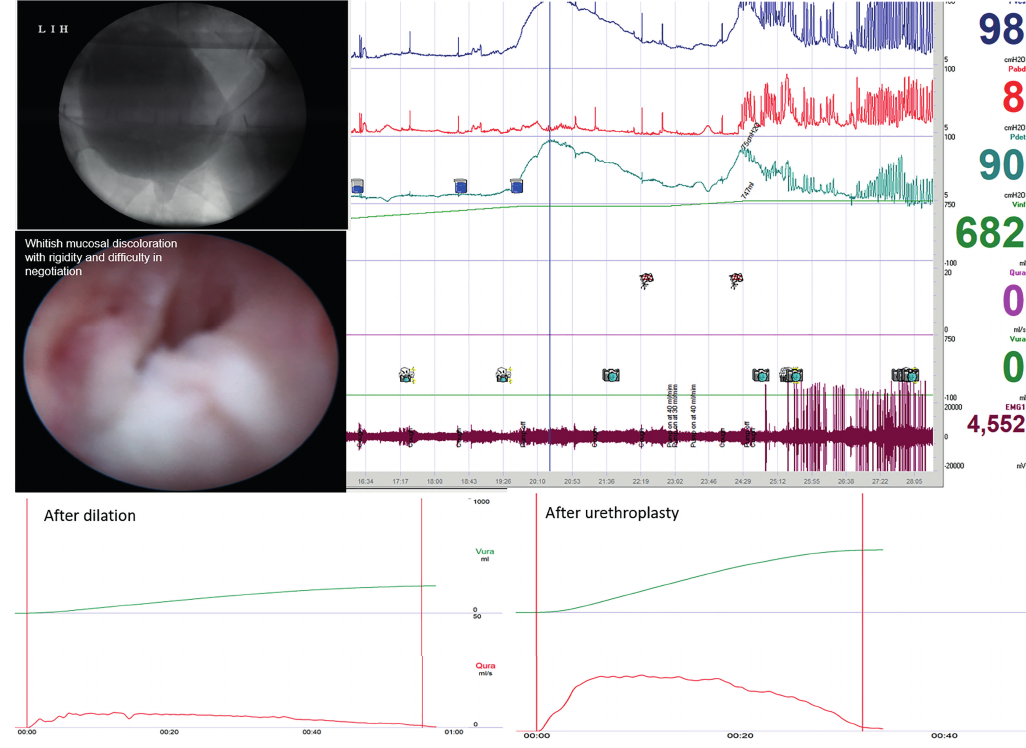
Figure 4 - 54-year-old lady with IPSS (28) with successful calibration showing VUDS and urethroscopic correlation with pDet@Qmax 90cmH2O, inability to void with proximal urethral ballooning evident during VUDS, stigmata of stricture as a whitish mucosal discoloration and rigidity and poor distensibility on urethroscopy, Qmax after endodilation was ~5mL/s and after urethroplasty